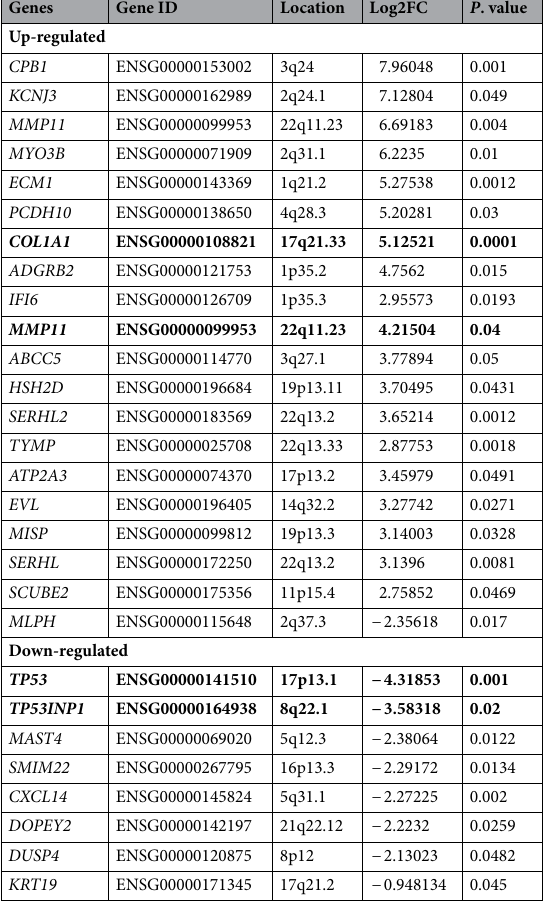
Table 3. Comparison of the gene over-expression in BC with NAT. Significant values are in bold.